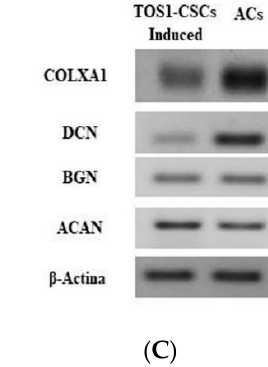
Figure 5. ALDH activity assay. The ALDH colorimetric assay detected high levels of ALDH activity in TOS1-CSCs cell line. However, the assay detected the absence of this activity in the finite differentiated cell line of fibroblasts, FIB48. Error bars: SD. *: p < 0.05 vs. FIB48.